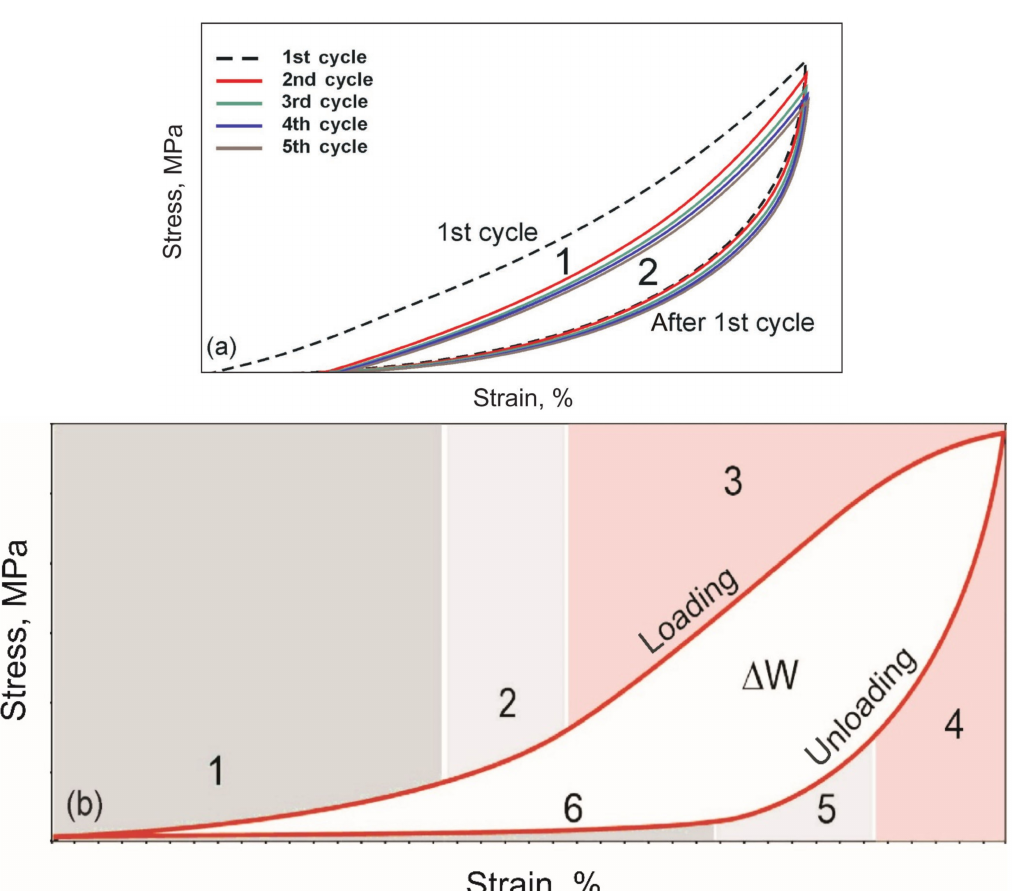
Figure 4. Schematic stress-strain curves of cyclic reversible tension of superelastic materials and biological tissues: ( a ) Mullins effect under cyclic tension; ( b ) single cycle with different deformation regions: 1—the initial linear region with low elastic modulus; 2 and 5—middle transition region of nonlinear deformation, 3—the final linear region with high elastic modulus, 4—elastic unloading region, 6—viscous unloading region. ∆ W is the energy dissipated in one loading-unloading cycle, which is the difference between the areas under the loading and unloading